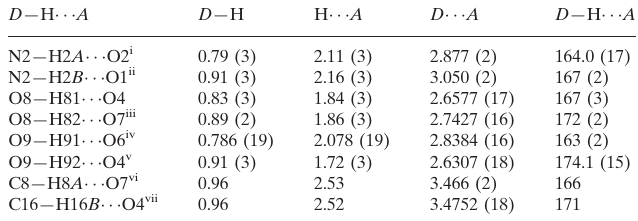
Hydrogen-bond geometry (A˚ , (cid:3)